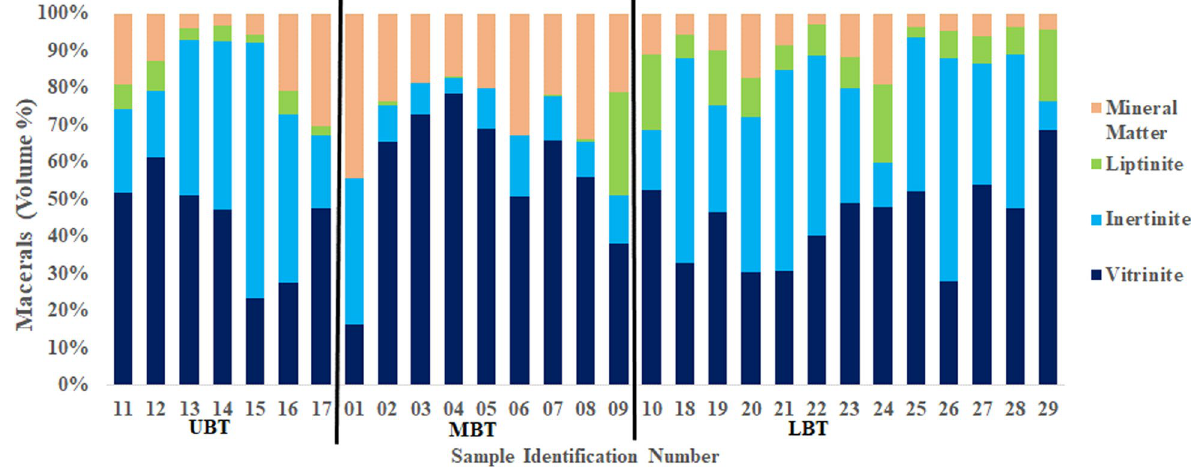
Fig. 3 Overview of maceral groups and mineral content (% by